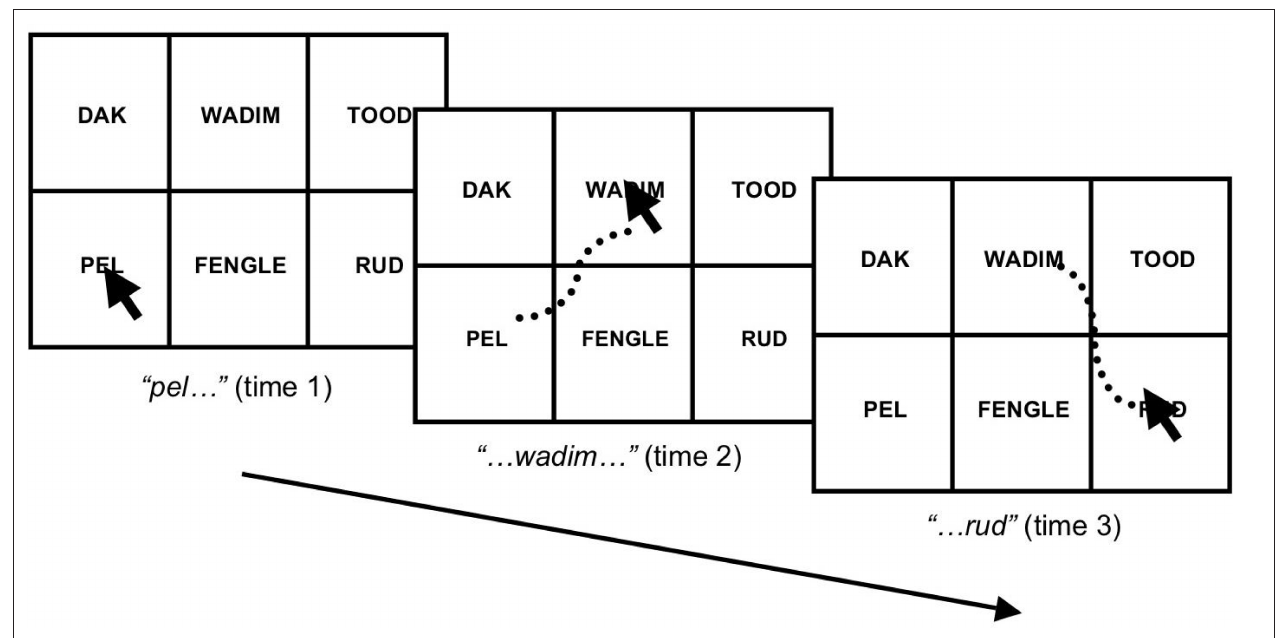
Figure 1 | The sequence of mouse clicks associated with the auditory stimulus string “ pel wadim rud ” for a single trial.